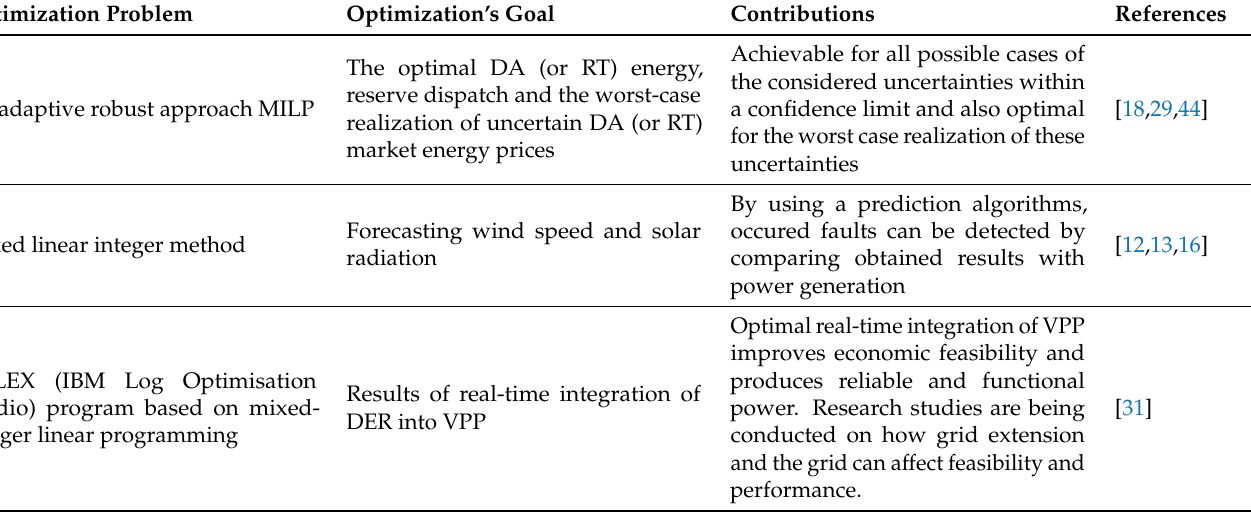
Table 2. Optimization problems on